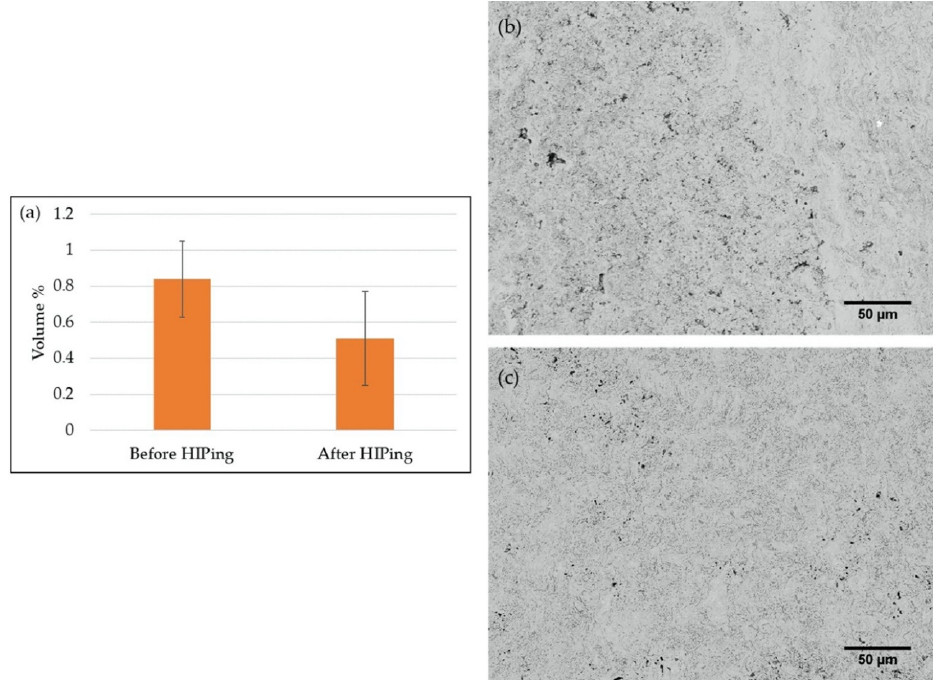
Figure 10. ( a ) Porosity content in the coatings before and after HIPing, as determined by image analysis, SEM micrographs of the coating ( b ) before HIPing, and ( c ) after HIPing.